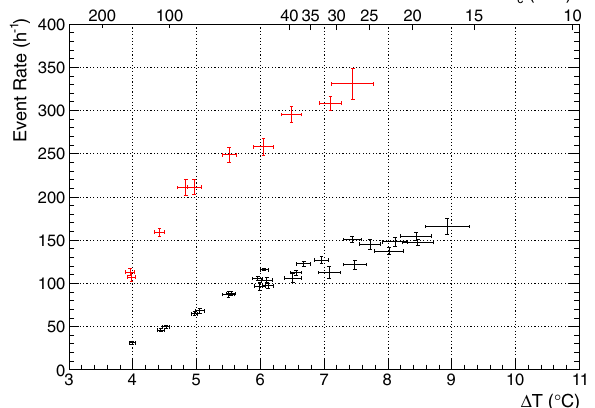
Fig. 8 Event rate versus superheat degree, and the corresponding energy threshold, with and without the 40 kBq AmBe neutron source. Horizontal error bars represent the standard deviation of the (cid:2) T distri- bution during the run